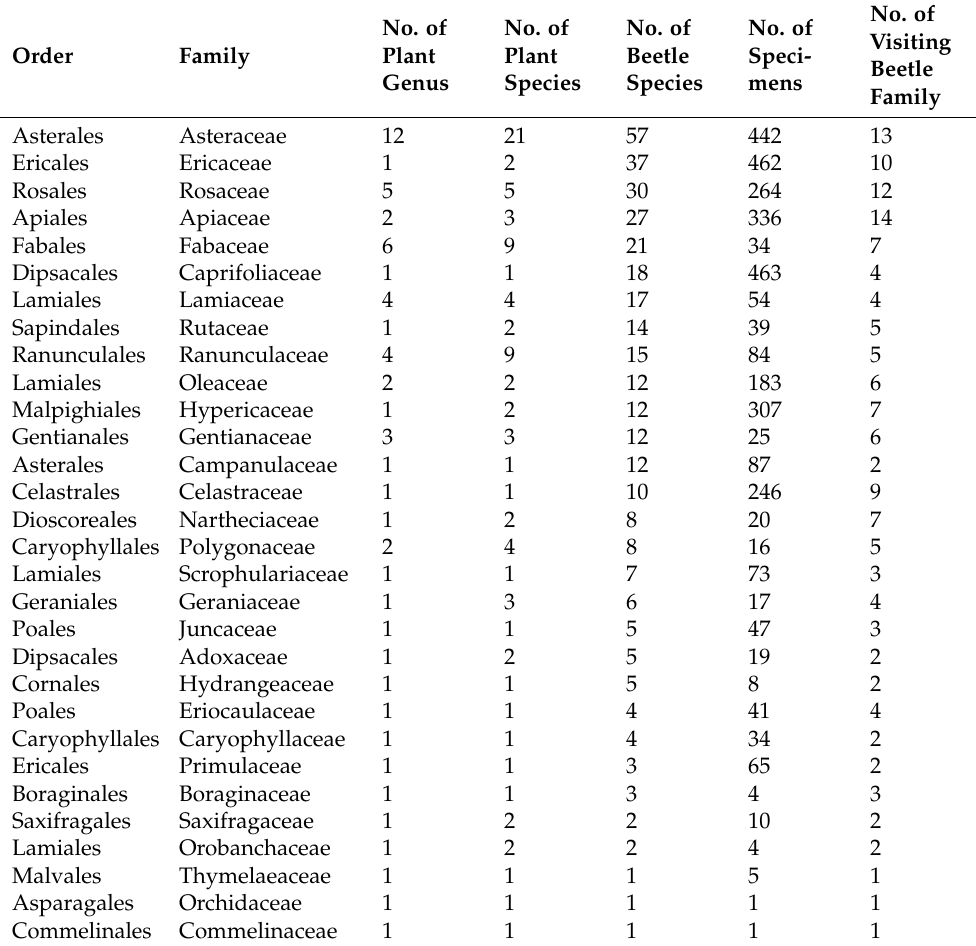
Table 2. Classification and identification of plant species and the relative abundance of beetle taxa visiting their